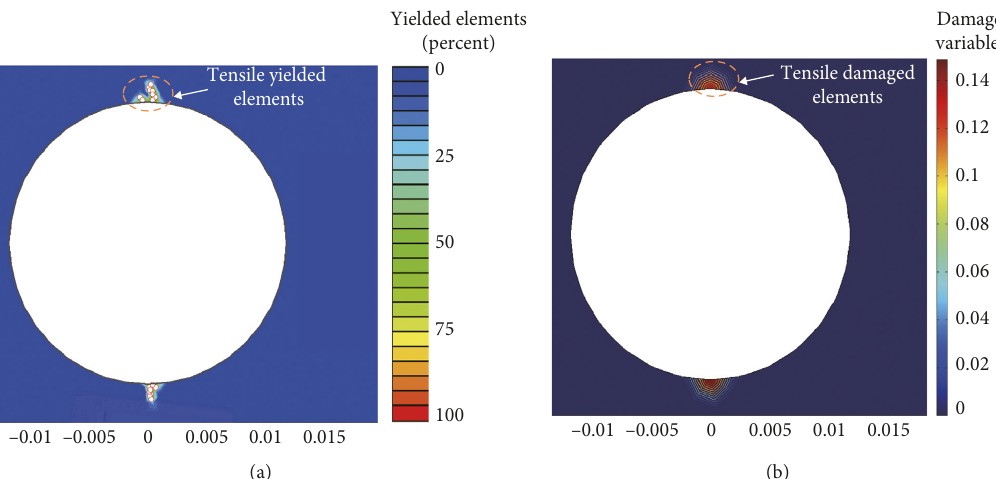
Figure 5: Tensile yielded elements or damaged elements surrounding borehole. (a) Yielded elements using Phase 2 software. (b) Damaged elements using method in this paper.